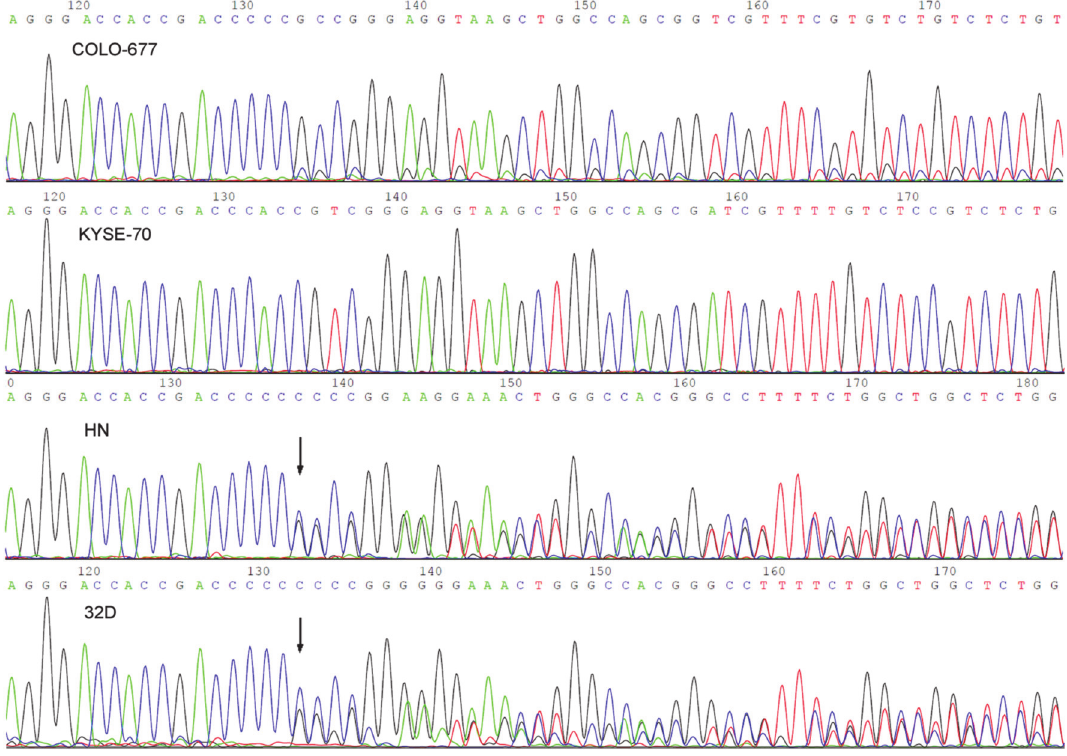
Fig 2. Direct DNA Sanger sequencing chromatograms showing sequence polymorphisms in the human cell lines COLO-677, KYSE-70, HN, and the mouse- derived cell line 32D. COLO-677 and KYSE-70 contain single sequences of MLV contaminants, whereas HN and 32D show identical chromatograms, indicating that the DNA of the human cell line was contaminated with mouse DNA. A single nucleotide deletion (arrows) results in a sequence shift leading to an overlap of two MLV sequences present in the mouse genomic DNA.